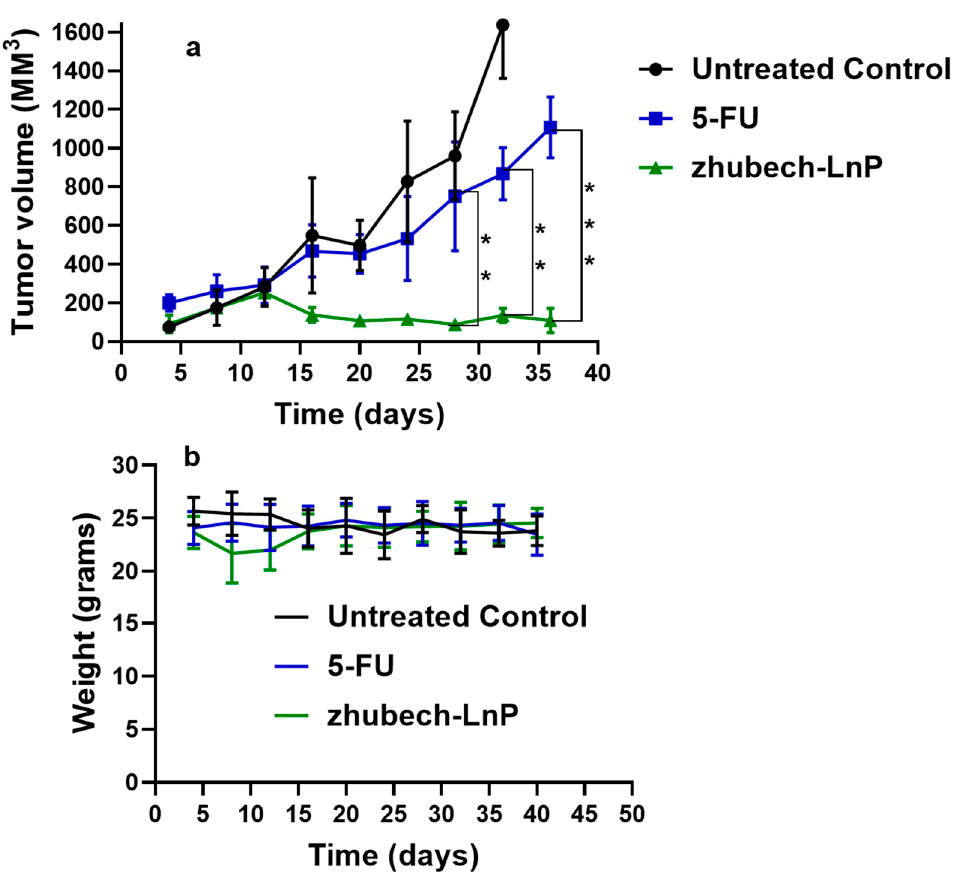
Figure 6. In vivo efficacy of Zhubech in PDX mouse model and chronic toxicity. ( a ) Tumor growth curves of 5-FU and Zhubech-treated mice bearing pancreatic PDX tumor and ( b ) body weight during treatment. Asterisks represents level of significance between control and treatment group (** p < 0.01, *** p < 0.001). All data represents mean ± SD, ( n = 4/group).